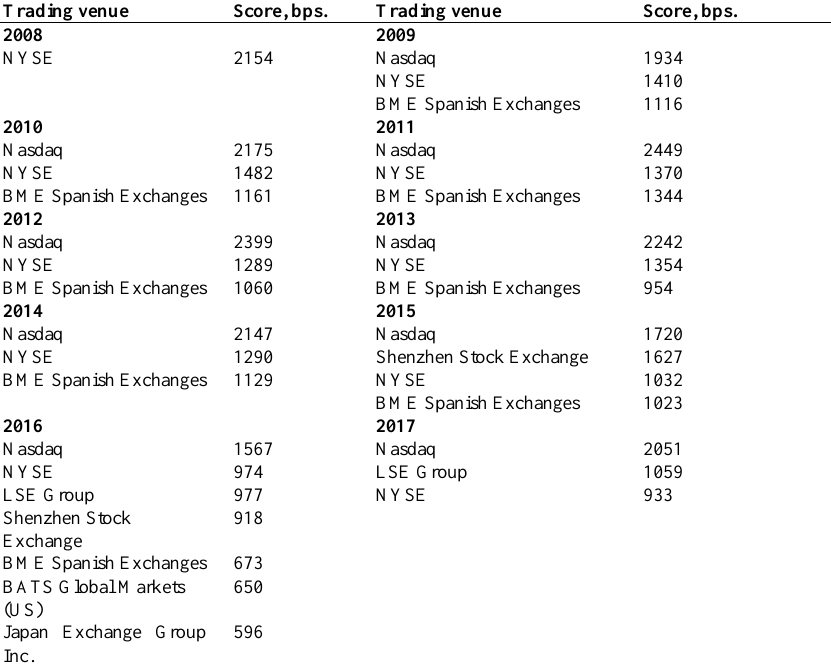
Table 8. Global systemically important trading venues for the “complexity”